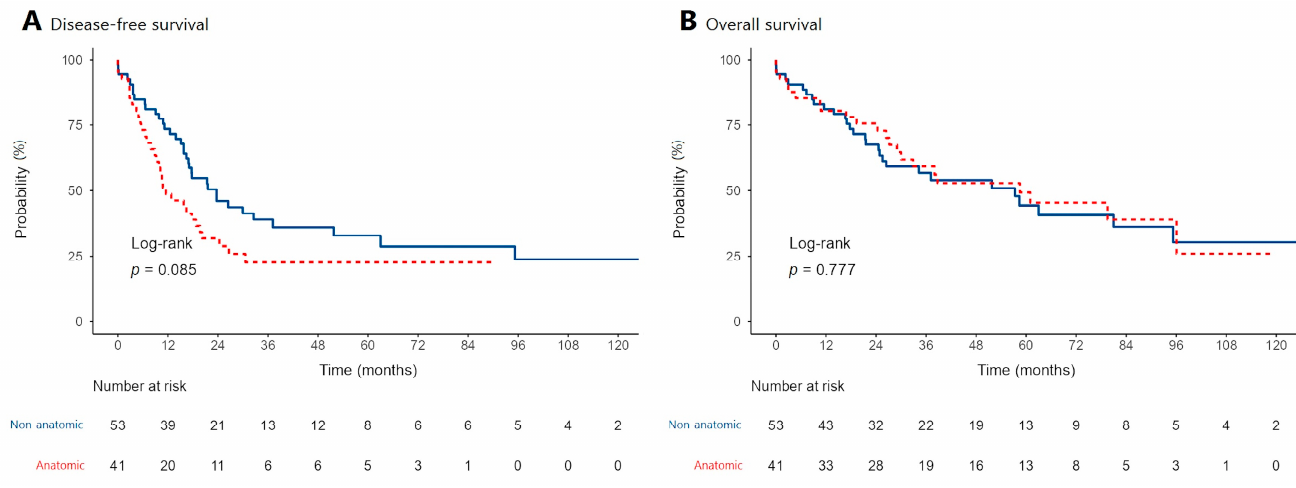
Figure 3. Kaplan–Meier curves showing disease-free ( A ) and overall survival ( B ) patterns of patients who underwent anatomic and non-anatomic liver resections for the treatment of hepatocellular carcinoma (HCC).